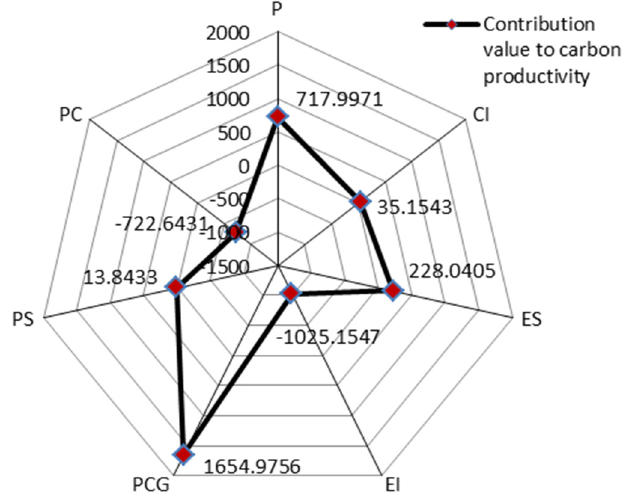
Figure 2. Contribution value to carbon